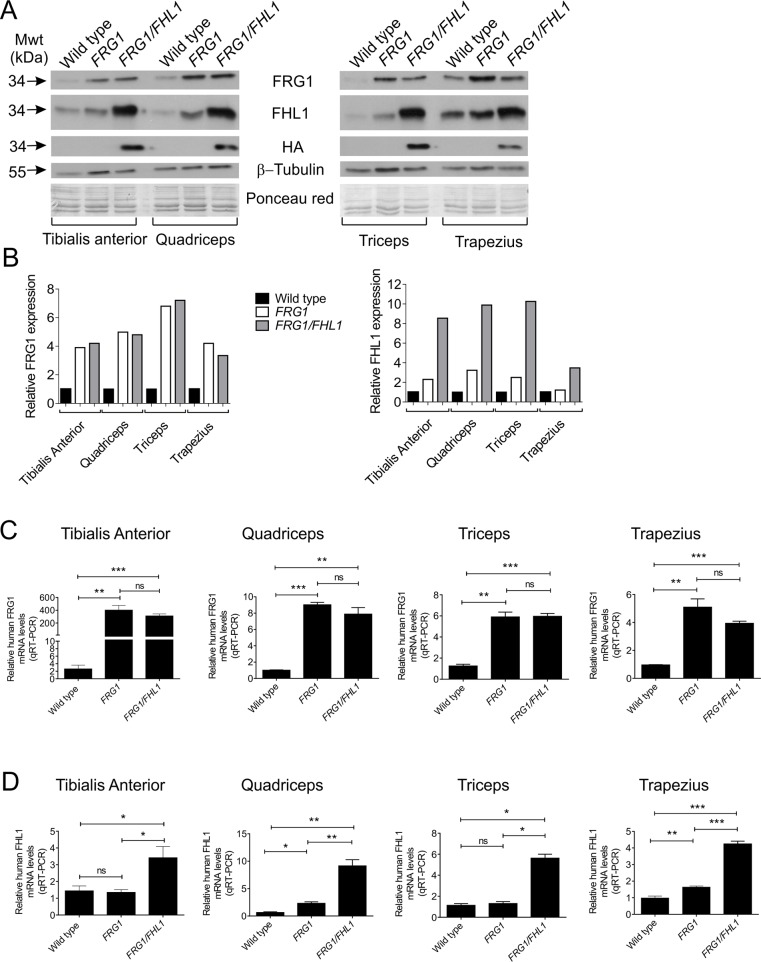
Generation of FRG1 and FRG1/FHL1 mice.(A) Immunoblot analysis of protein expression in the tibialis anterior, quadriceps, triceps and trapezius muscles from wild type, FRG1 and FRG1/FHL1 mice. HA-tagged FHL1 was detected using a HA-specific antibody; β-tubulin immunoblotting and ponceau red staining of membranes were used as loading controls. (B) Relative FRG1 and FHL1 expression levels in the tibialis anterior, quadriceps, triceps and trapezius muscles from wild type, FRG1 and FRG1/FHL1 mice. Protein expression was quantified using densitometry. Quantitative RT-PCR analysis of FRG1 (C) and FHL1 (D) mRNA in muscles from wild type, FRG1 and FRG1/FHL1 mice. Data represent the mean from n≥4 mice/genotype; *p<0.05, **p<0.005, ***p<0.001 determined by two-tailed student’s T-test.